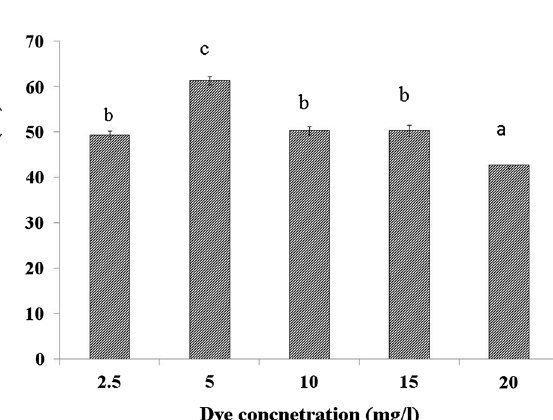
Fig. 3 Effect of incubation period